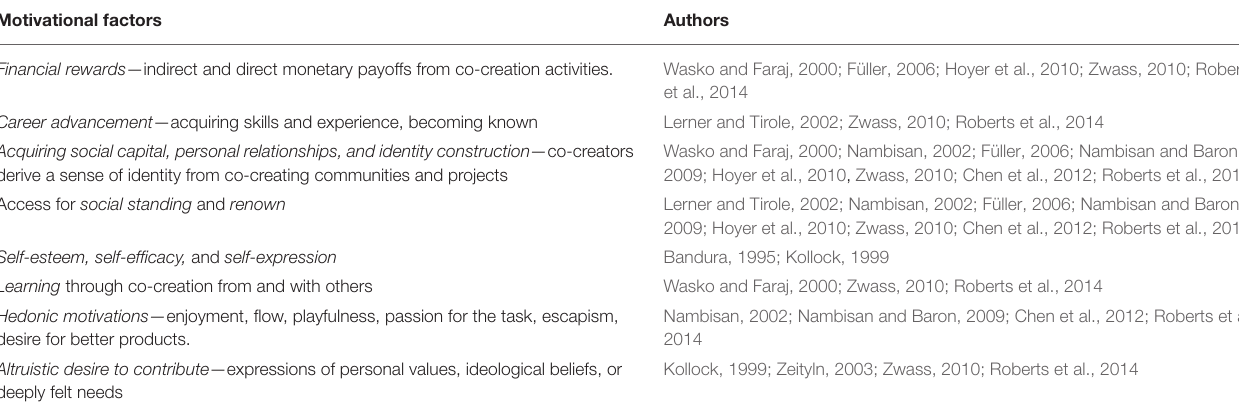
TABLE 2 | Consumers’ motives for participating in co-creation processes. Motivational factors